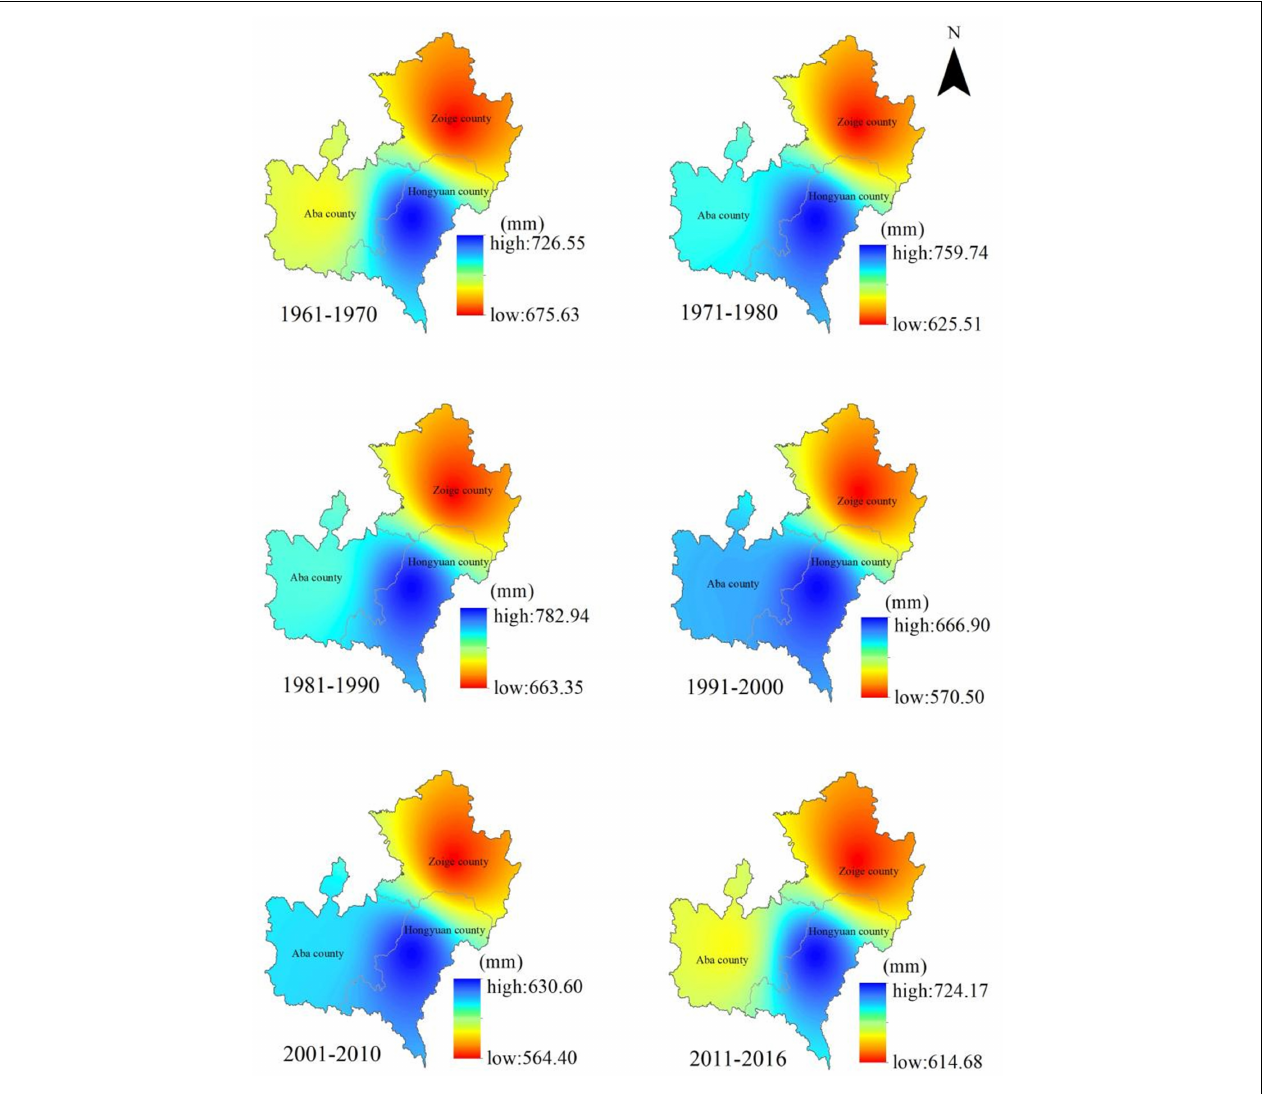
FIGURE 4 | Average annual precipitation from 1961 to